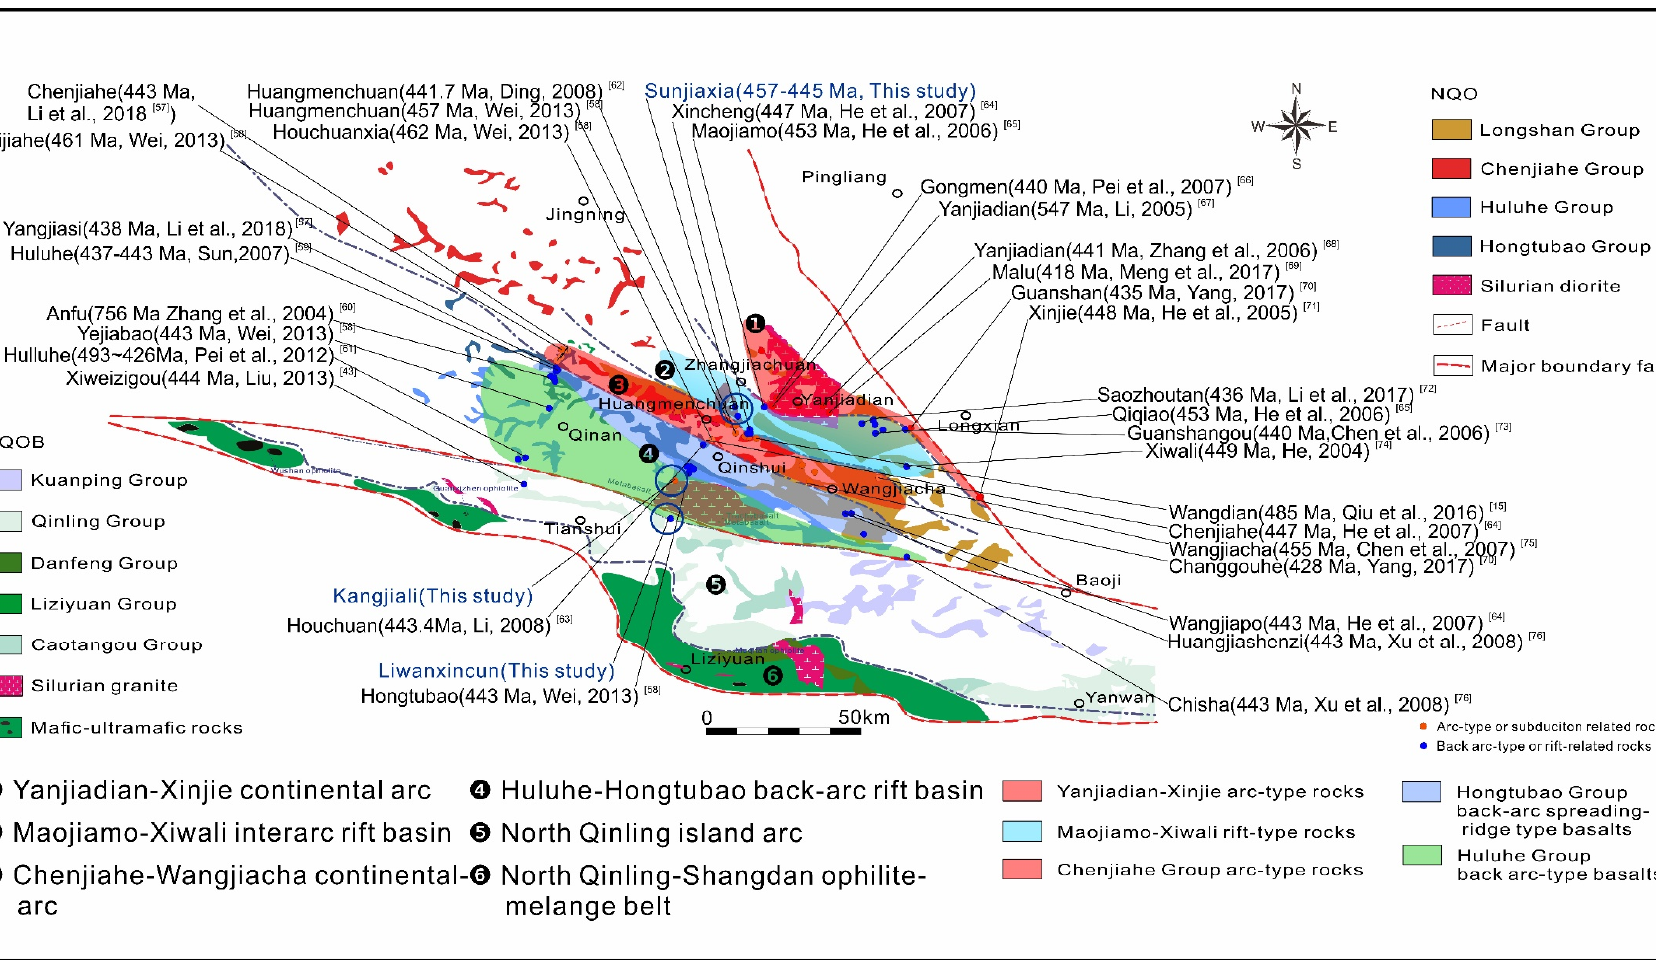
Figure 18. Tectonic setting map showing the ages and distributions of Early Paleozoic igneous rocks and the division of tectonic units in the Sunjiaxia-Tianshui area. The corresponding ages, methods, locations and references [7,15,43,57–76] are listed in Table 1.